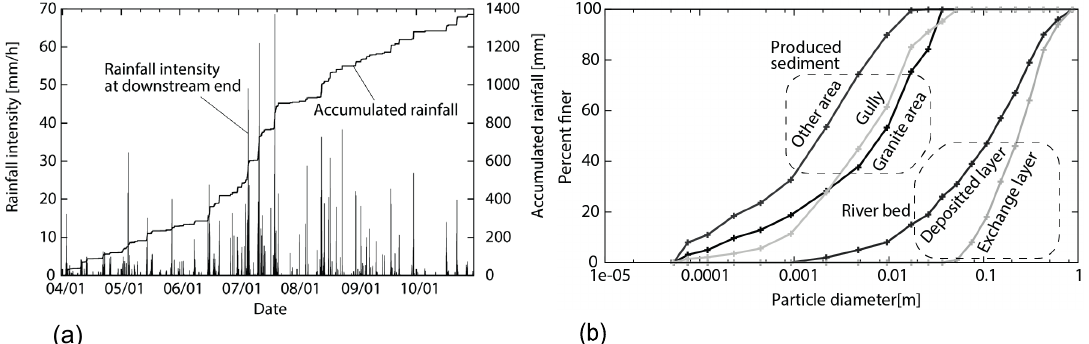
Fig. 5 (a) Rainfall data at the downstream end in 2012. (b) Grain size distribution in each geological